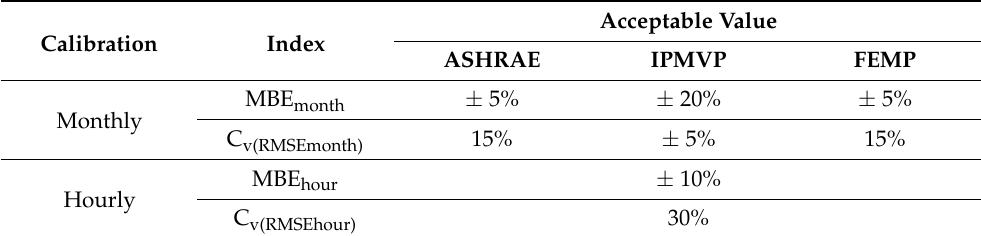
Table 5. Acceptable value of the energy simulation model suggested by the M&V (measurement and verification) guidelines (DOE,